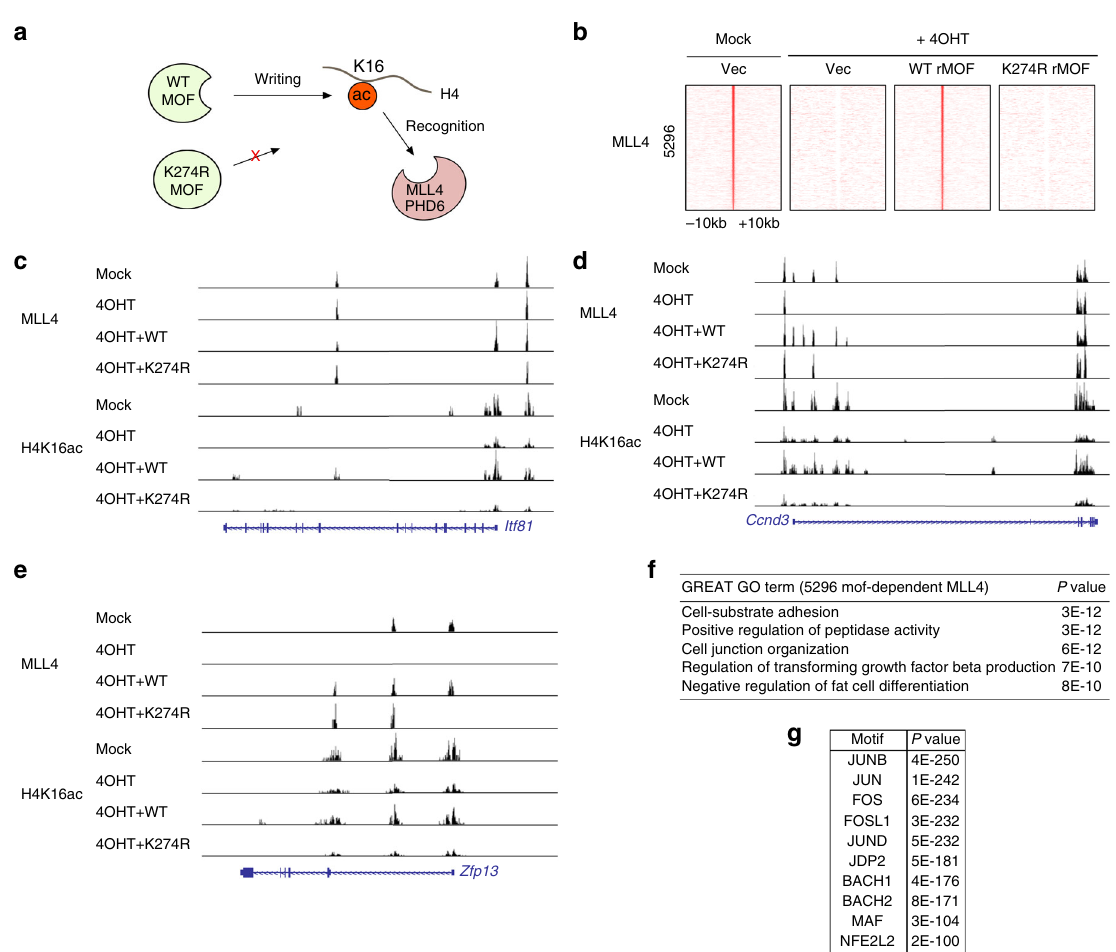
Fig. 6 MOF (Males absent On the First) catalytic activity is necessary for Mof -dependent chromatin targeting of MLL4. Mof f/f ; Cre-ER brown preadipocytes were infected with lentiviruses expressing wild-type (WT) or enzyme dead mutant (K274R) form of rMOF, followed by 4-hydroxytamoxifen treatment. Cells were collected for chromatin immunoprecipitation – sequencing (ChIP-Seq) analysis of MLL4 and H4K16ac. a Schematic representation of WT and enzyme dead MOF. b Heat maps of 5296 MOF enzyme activity-dependent MLL4-binding sites. c – e ChIP-Seq pro fi les of MLL4 and H4K16ac on Zfp13 ( c ), Ccnd3 ( d ), and Itf81 ( e ) gene loci. f Gene ontology analysis of the genes associated with 5296 MOF catalytic activity-dependent MLL4-binding regions. g AP-1 family transcription factor motifs are enriched at MOF catalytic activity-dependent MLL4-binding regions. Top 3000 MLL4-binding regions